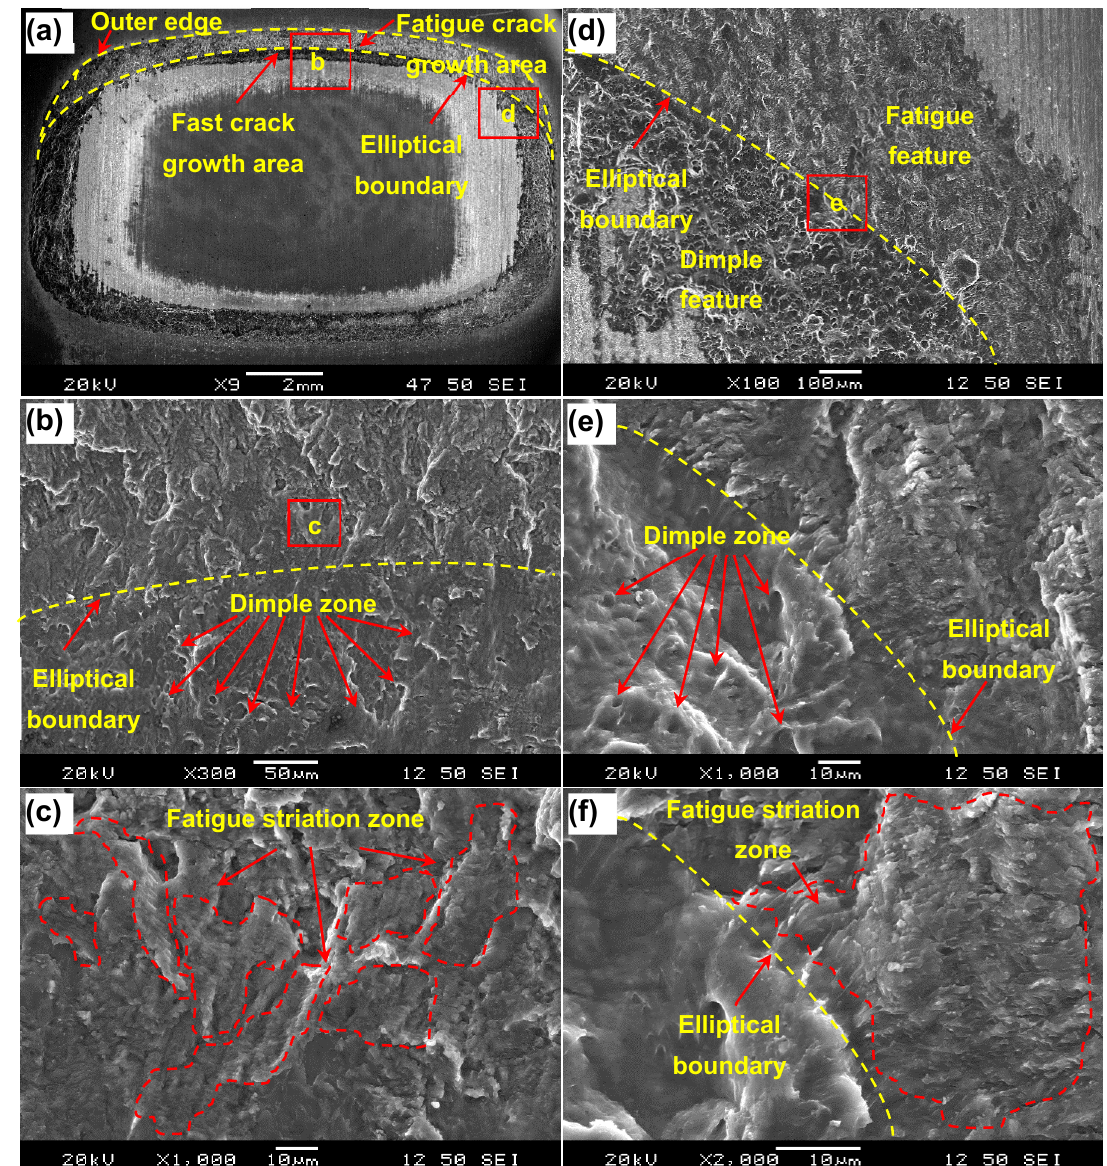
Figure 4. Fracture surface characteristics of an EMPWed Al / Cu dissimilar lap joint fatigued at P max = 1 kN on the Cu side. ( a ) Overall view of the fracture surface; ( b ) typical dimples and elliptical boundary of top side; ( c ) fatigue striation zone of top side; ( d ) fatigue and dimple features and elliptical boundary of right side; ( e ) typical dimple zone of right side, and ( f ) fatigue striation zone of right side.